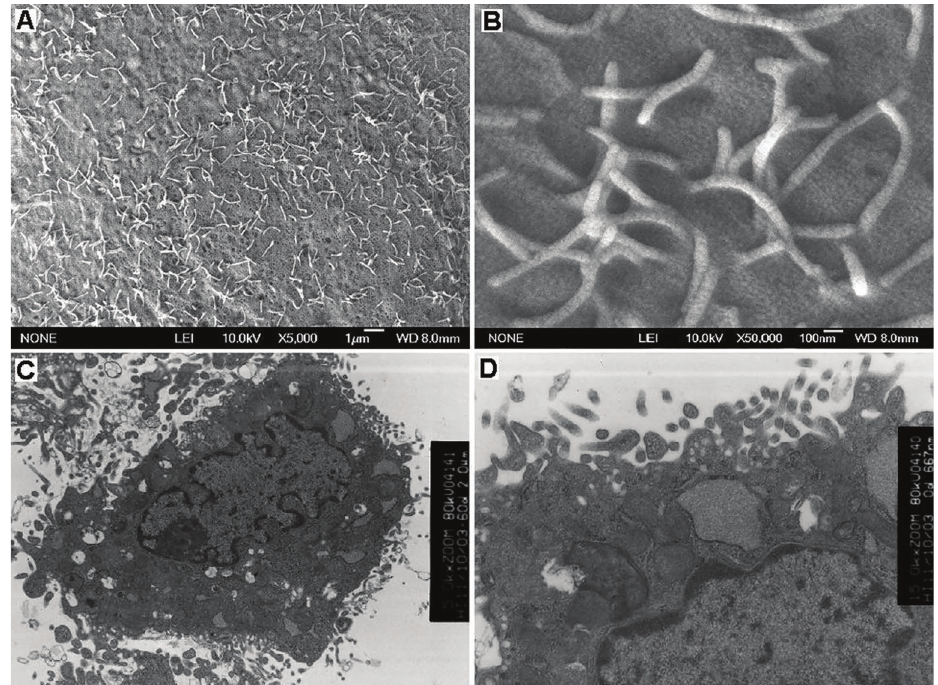
Figure 4. Ultrastructural characteristics of mouse intestinal epithelial cells (IECs). Scanning electron microscopy (SEM) showed that abundant microvilli were observed on the apical surface of the IECs ( A , B ). Transmission electron microscopy (TEM) of a